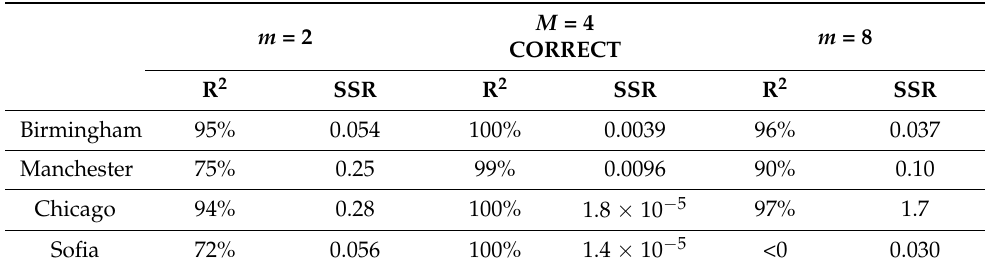
Table 3. Sensitivity of the different methods to the choice of m. R 2 and SSR between validation DSD and predicted DSD, making different assumptions of m, when using the methods to estimate the fragmentation rate. The validation data was created using m = 4 (‘CORRECT’). M = 4 m = 2 m = 8 CORRECT R 2 SSR R 2 SSR R 2 SSR Birmingham 95% 0.054 100% 0.0039 96% 0.037 Manchester 75% 0.25 99% 0.0096 90% 0.10 Chicago 94% 0.28 100% 1.8 × 10 − 5 97% 1.7 Sofia 72% 0.056 100% 1.4 × 10 − 5 <0